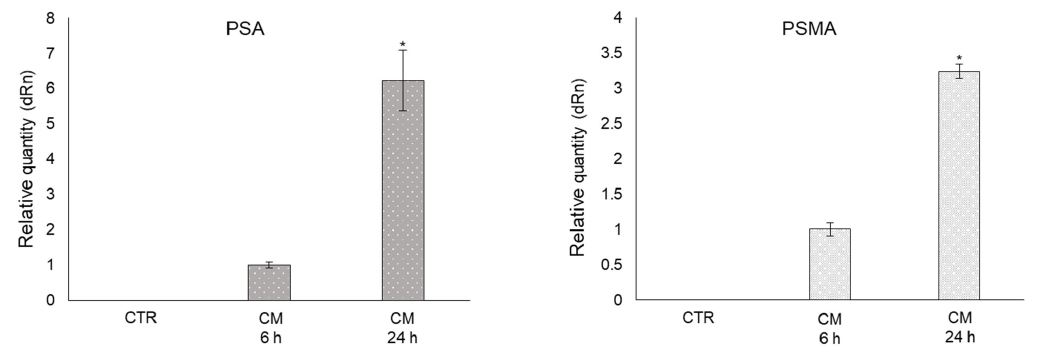
Figure 8. Conditioned medium (CM) from PC3 cells induces de novo expression of the prostate-specific antigens PSA and PSMA (prostate-specific membrane antigen) in OB. Transcript levels were evaluated by real-time PCR in OB exposed for 6 and 24 h to CM from PC3 cells. Control cells (CTR) are represented by OB cultured for the same period of time in their specific growth medium. Two experimental CTRs were performed for each exposure time; being both of them set at 1, each histogram reports only one CTR. The histogram indicates the mean ± SD of two different cultures, and each was tested in triplicate. * p < 0.05.